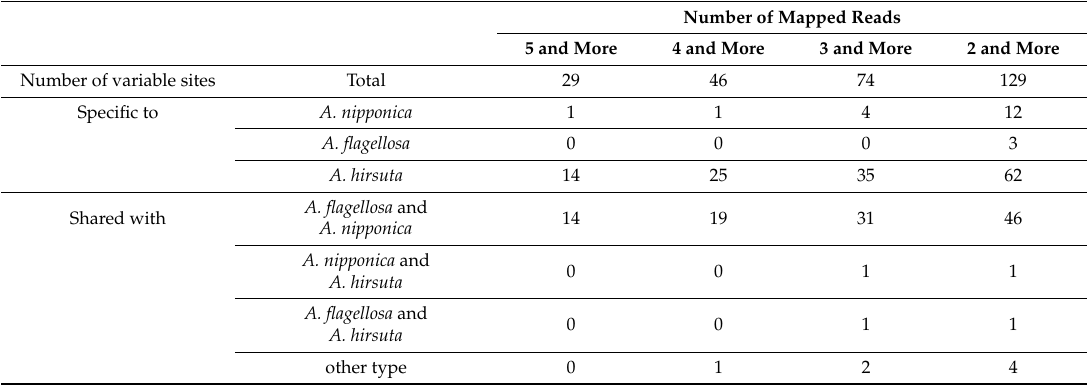
Table 4. Nucleotide variation in the mitochondrial genome of Arabis